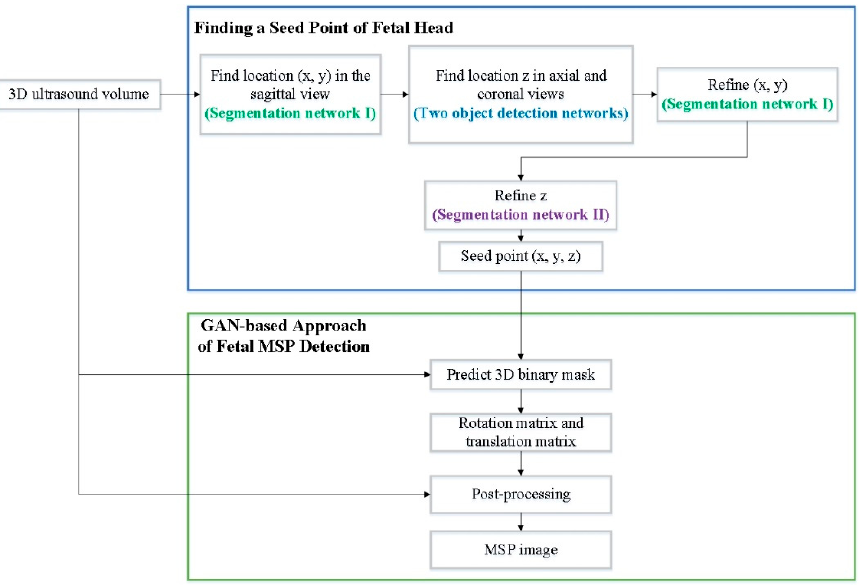
Figure 1. Flow diagram of automatic middle sagittal plane (MSP) detection using generative adversarial networks (GANs).